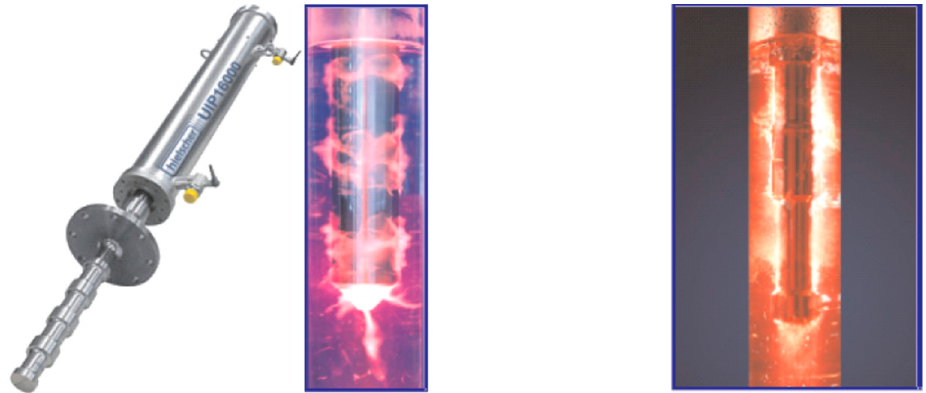
Figure 32. Rod ultrasonic transducer and its better cavitation in water.